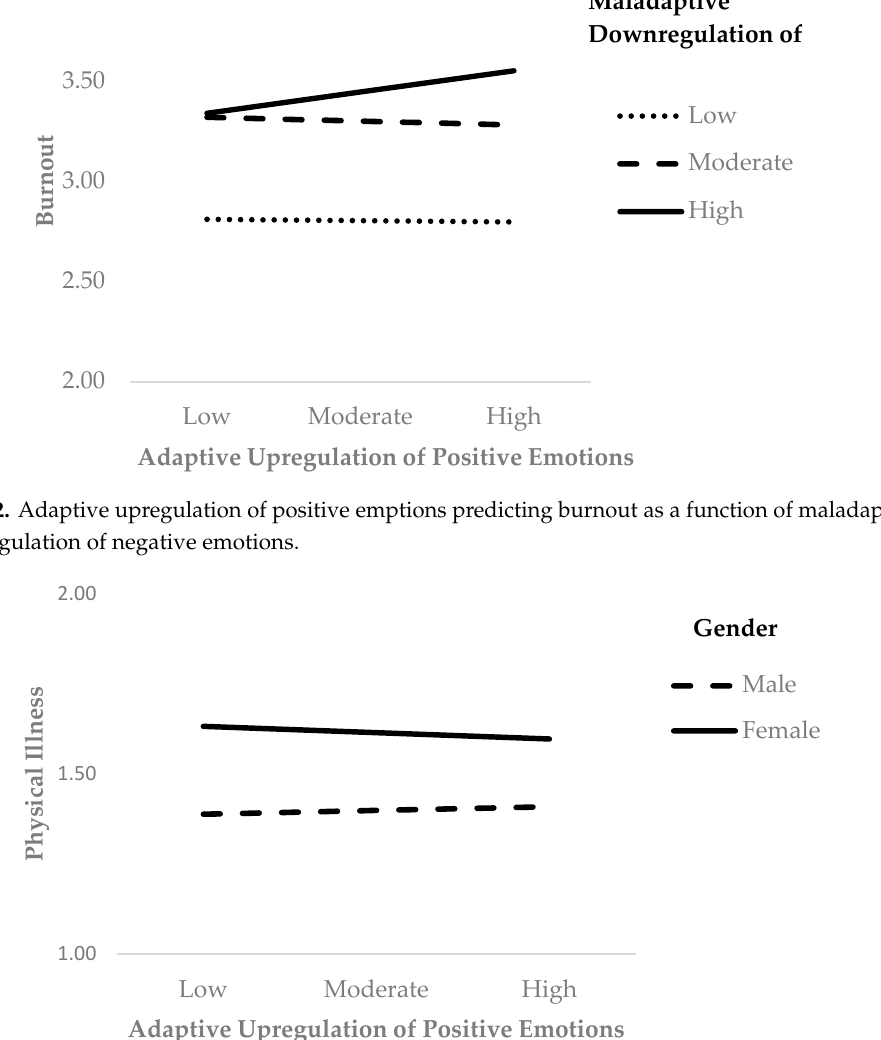
Figure 2. Adaptive upregulation of positive emptions predicting burnout as a function of maladaptive downregulation of negative emotions.